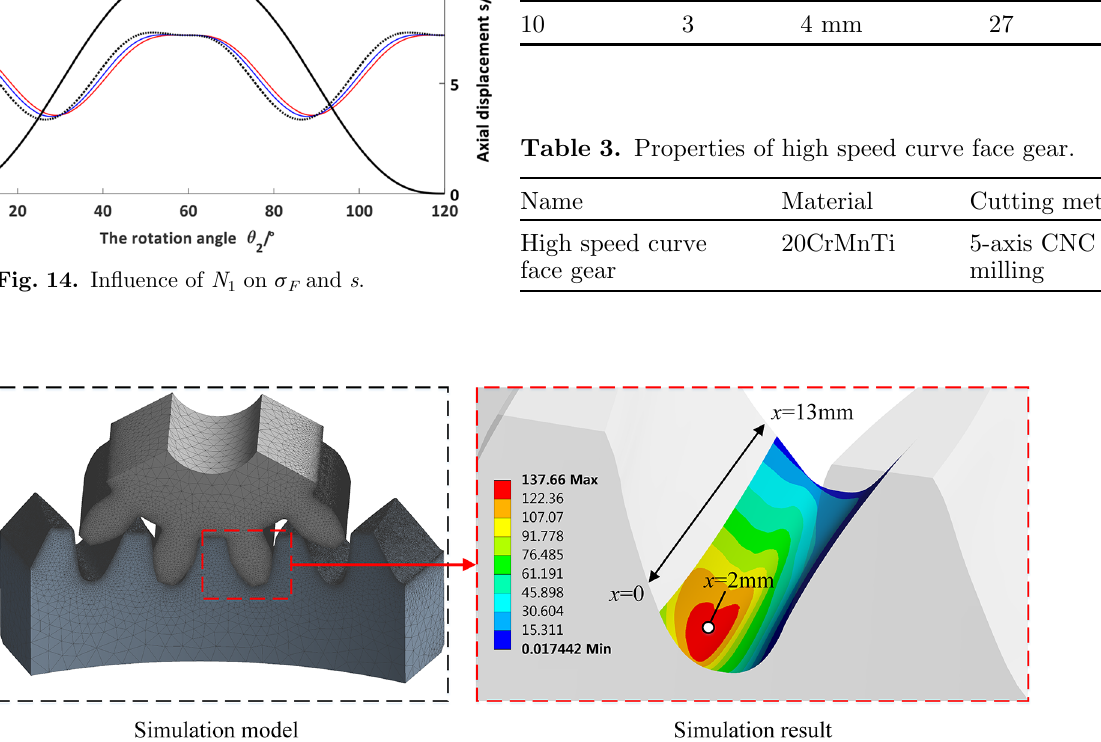
Fig. 15. Simulation of tooth root bending stress.